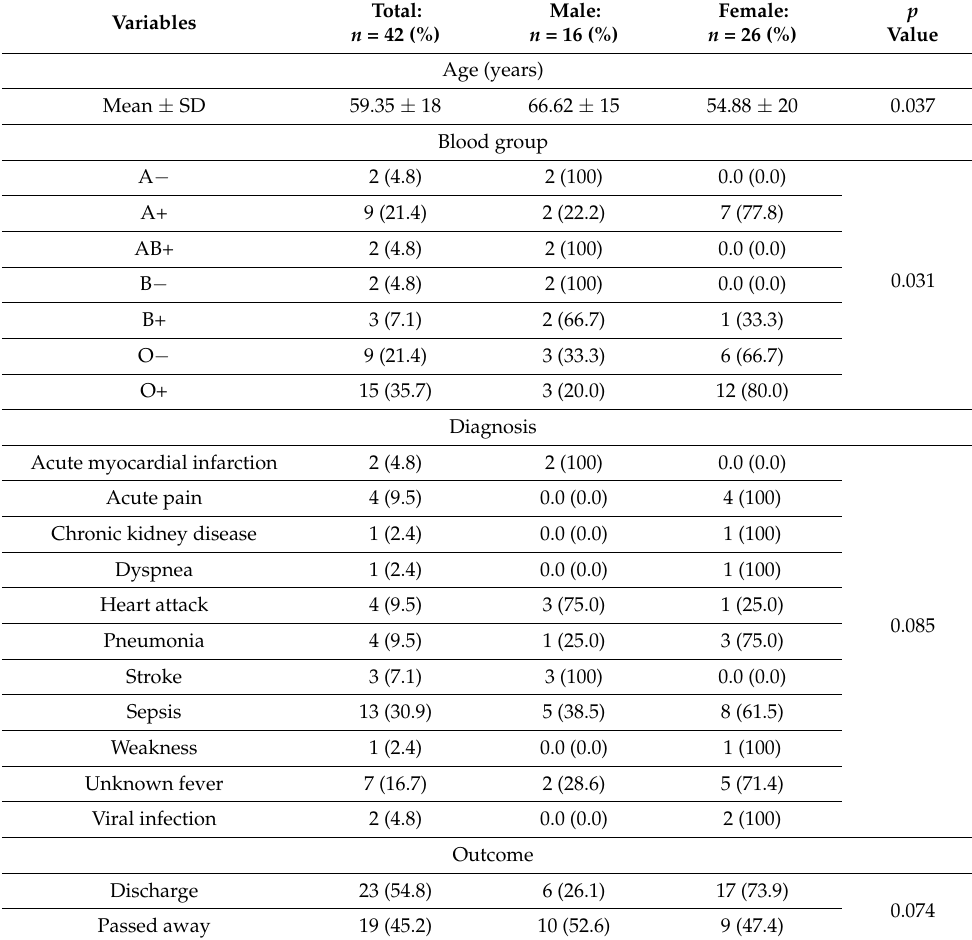
Table 1. Characteristics and medical history variables of the study participants by